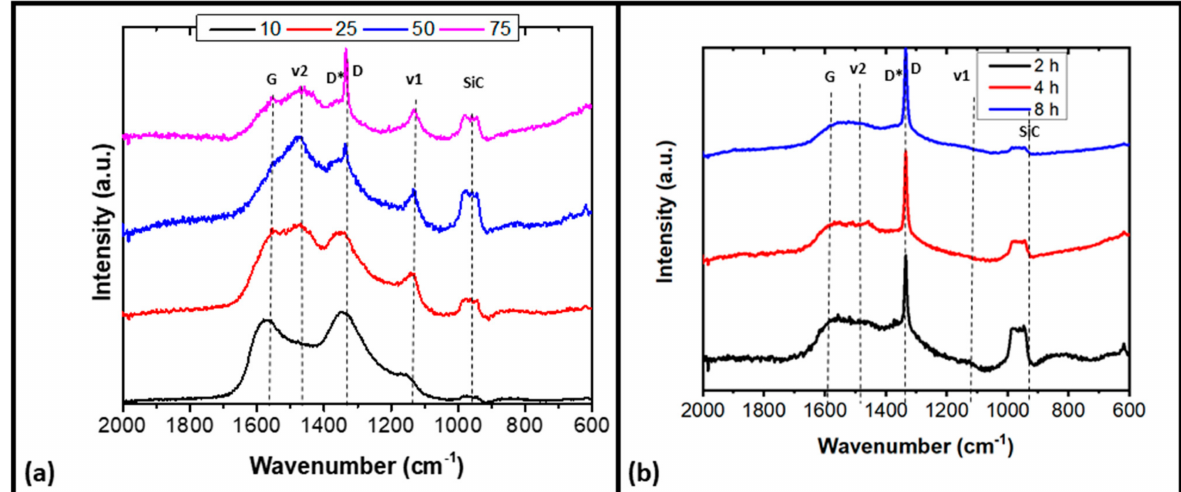
Figure 6. ( a ) Raman spectra from PCD films grown with H 2 :Ar:CH 4 ratios of 10:90:2, 25:75:2, 50:50:2, and 75:25:2 sccm flow during film growth. ( b ) MCD films grown with H 2 (200 sccm):CH 4 (3 sccm) gas mixture flow for different growth times (the 2, 4, and 8 h samples correspond to E, F, G in Table 1). (The peaks are indicated by the excitation modes, where D* is the broad peak from disordered carbon and D is from crystal